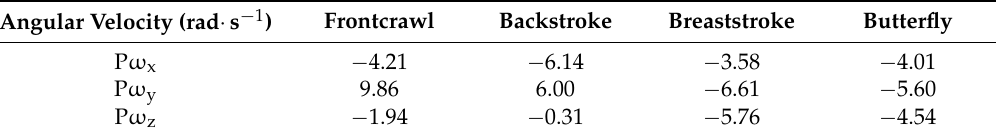
Table 6. Angular velocity during turns. Sample data adapted from Vannozzi, Donati, Gatta and Cappozzo [47], providing indicative values of peak angular velocity (P ω ) during turns performed for each of the four competitive swimming